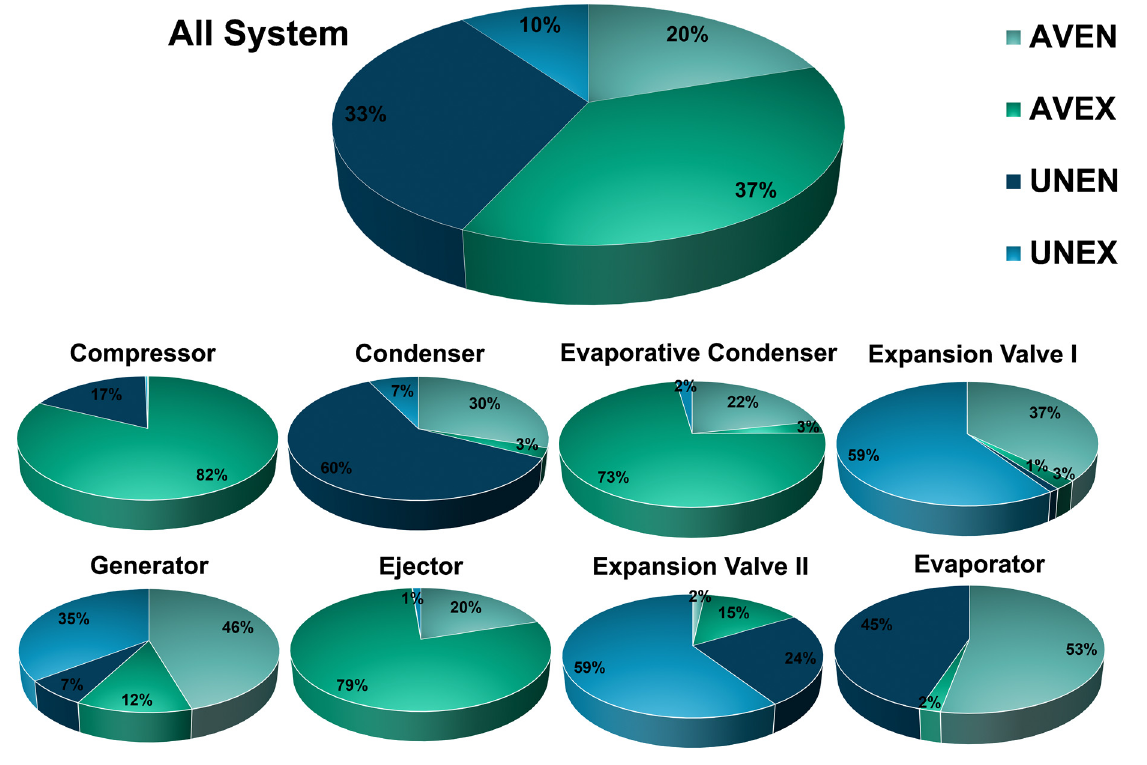
Figure 7. Percentage exergy destruction rate of system components.